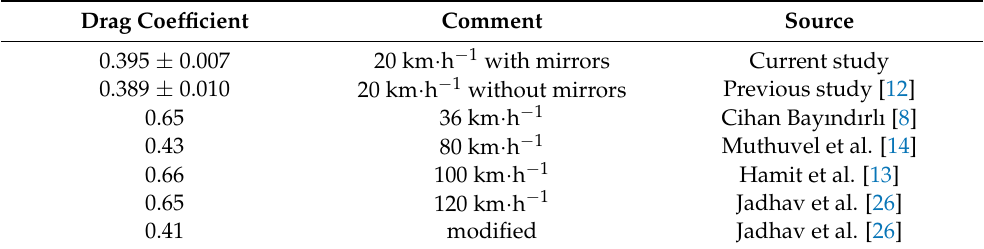
Table 5. Drag coefficients.